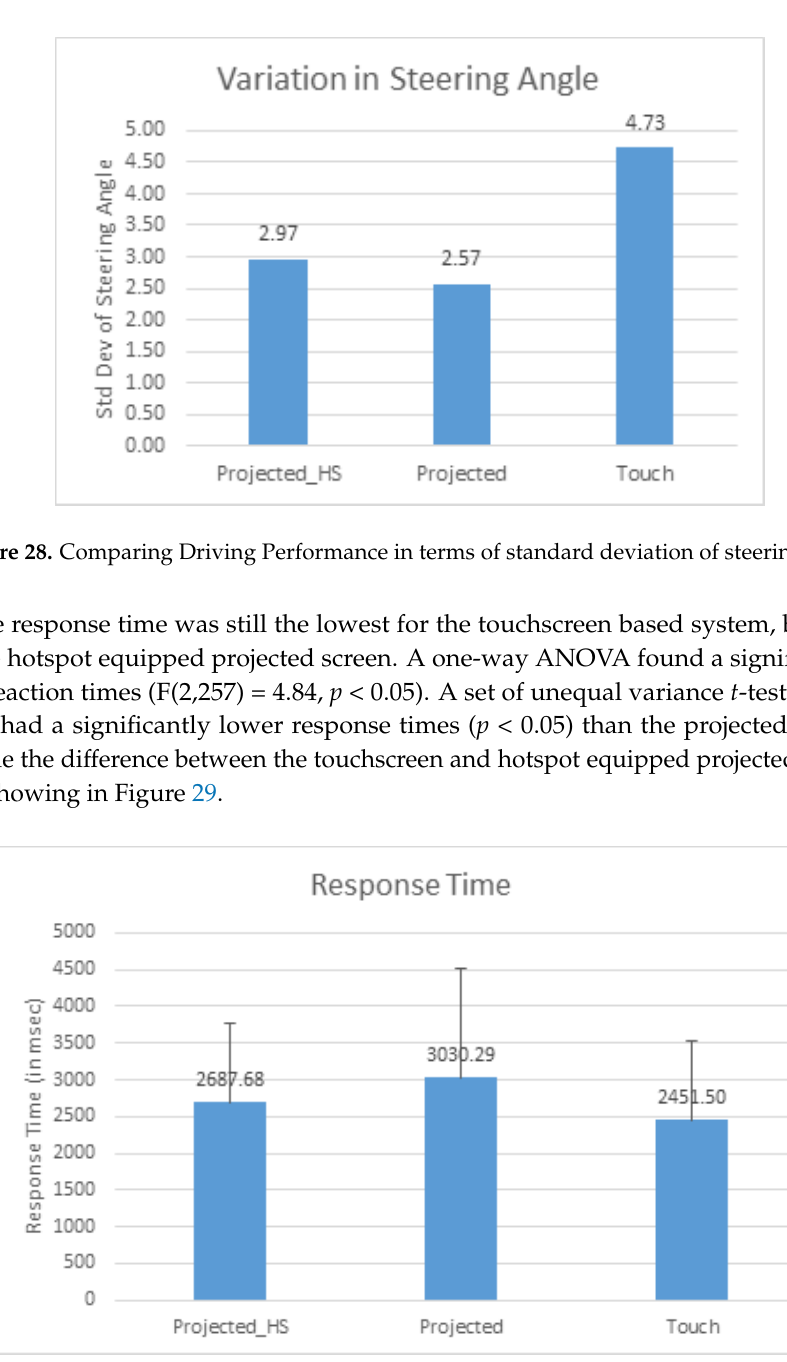
Figure 29. Comparing average response times.